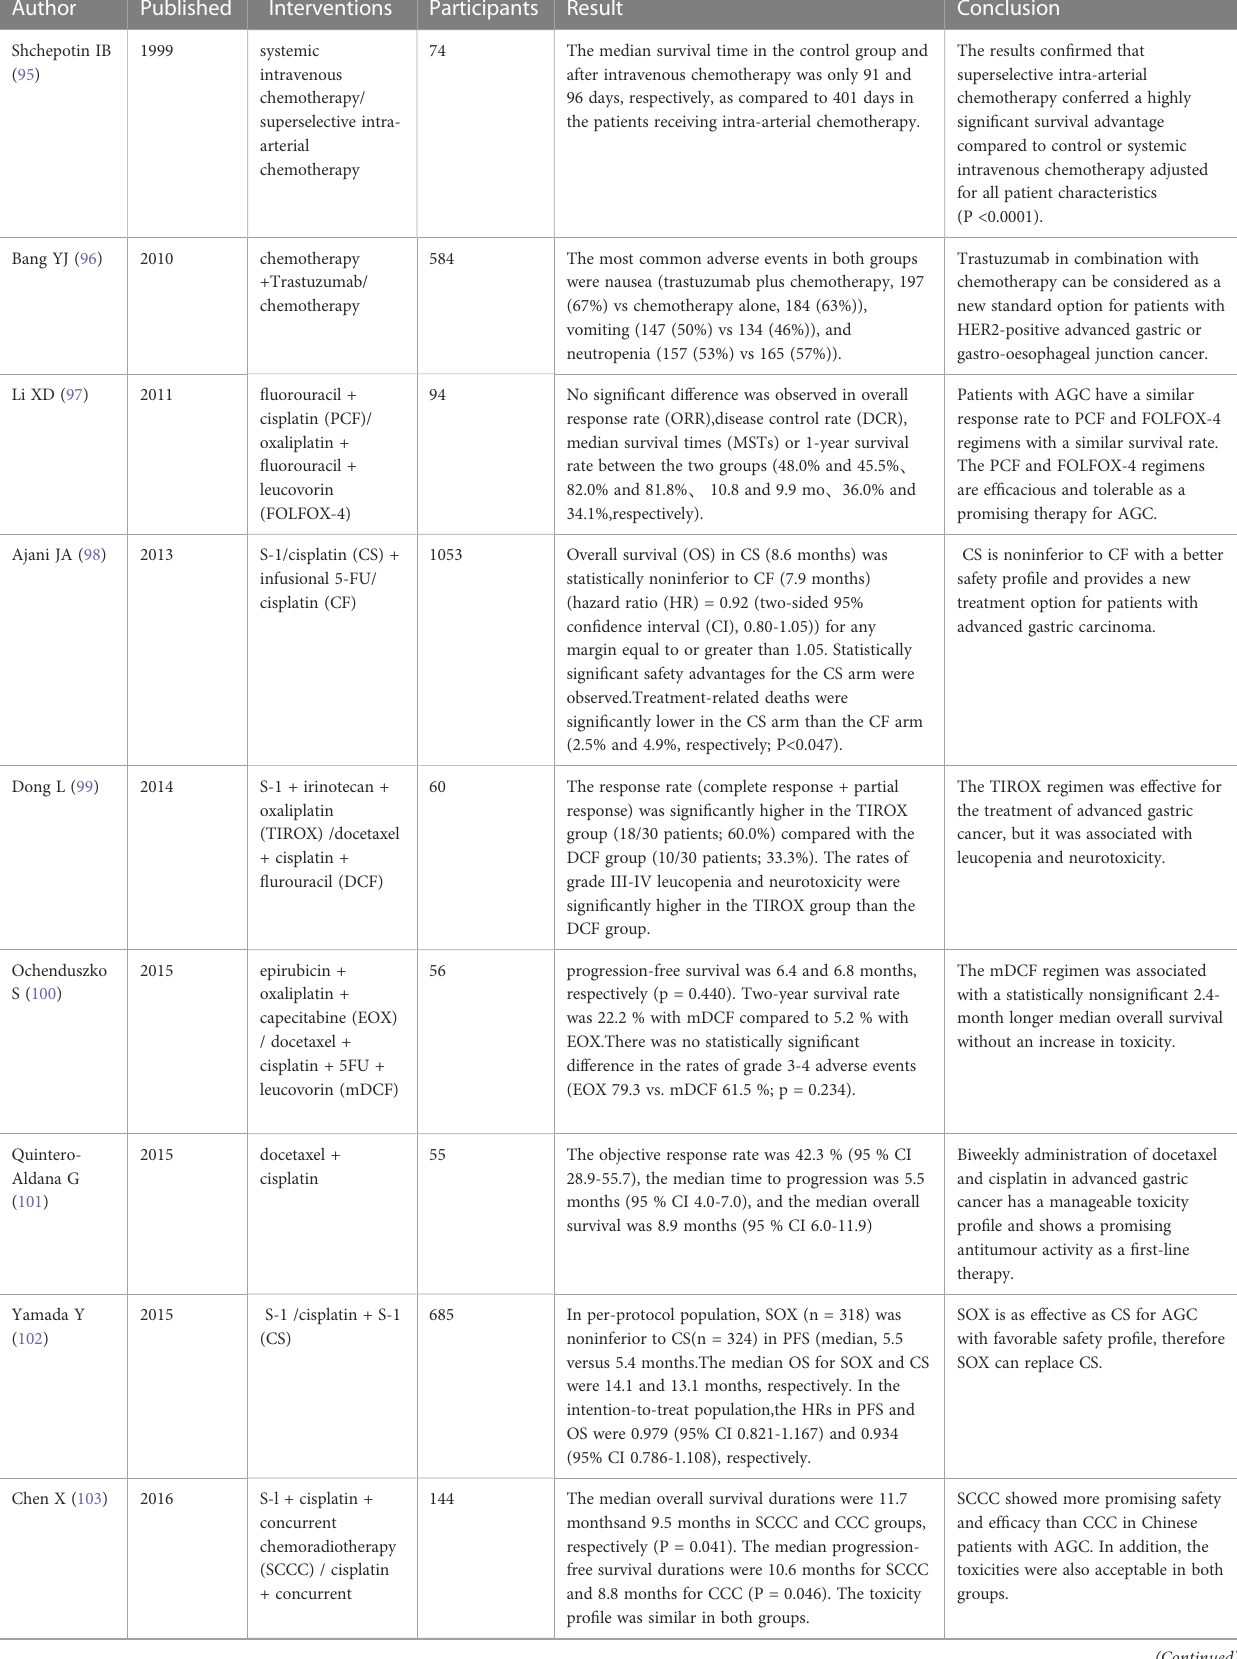
TABLE 4 Recent clinical trials of chemotherapy on palliative treatment of advanced gastric